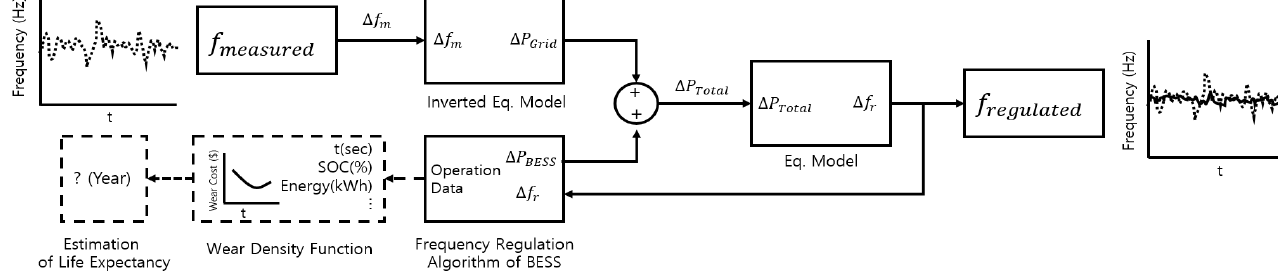
Figure 10. Equivalent model and BESS battery life expectancy model.